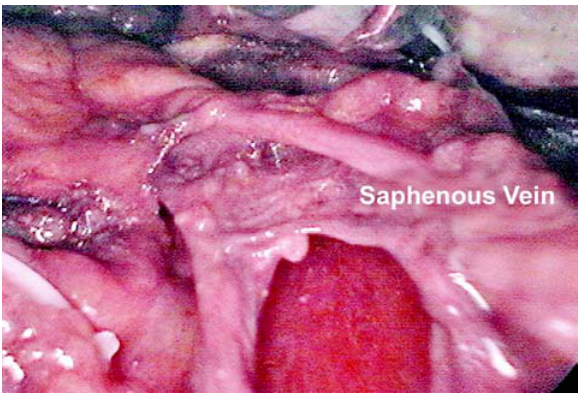
Figure 3 – Dissection of the long saphenous vein in a cranial aspect.